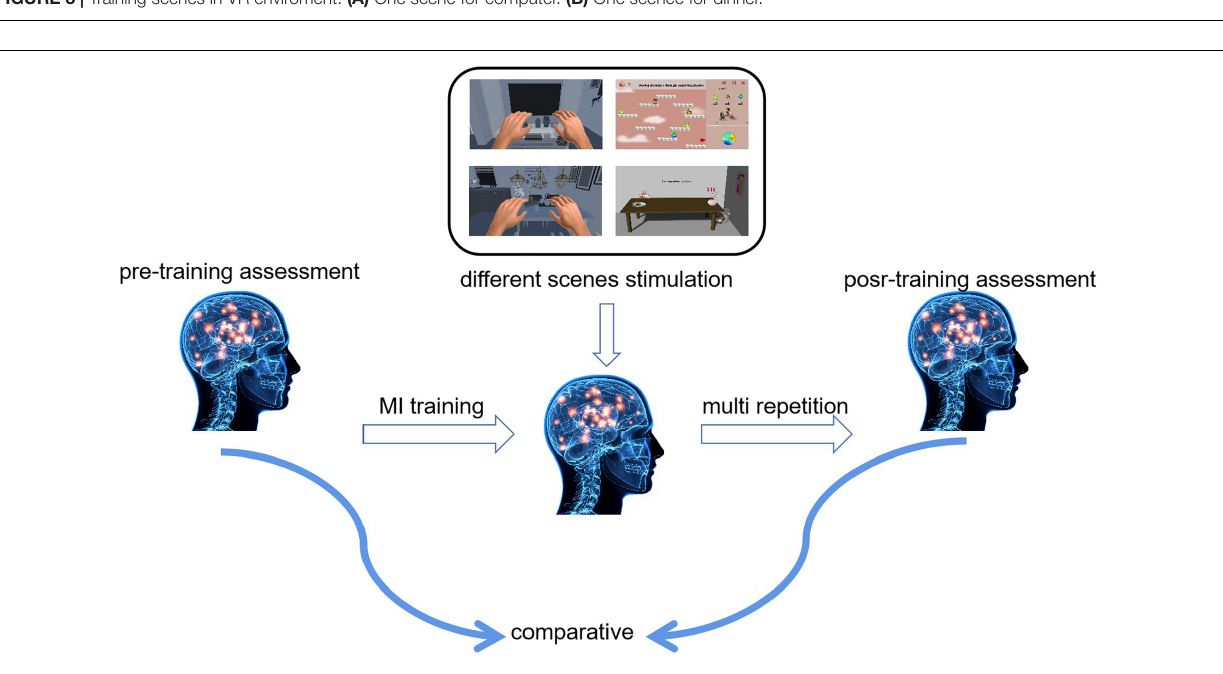
FIGURE 3 | Training scenes in VR enviroment. (A) One scene for computer. (B) One scence for dinner.